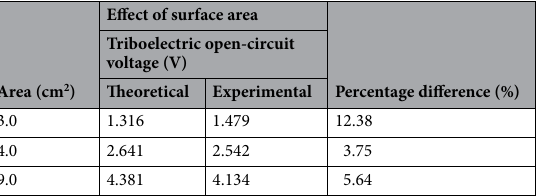
Table 2. Theoretical and experimental voltages from the triboelectric mechanism for different surface areas.